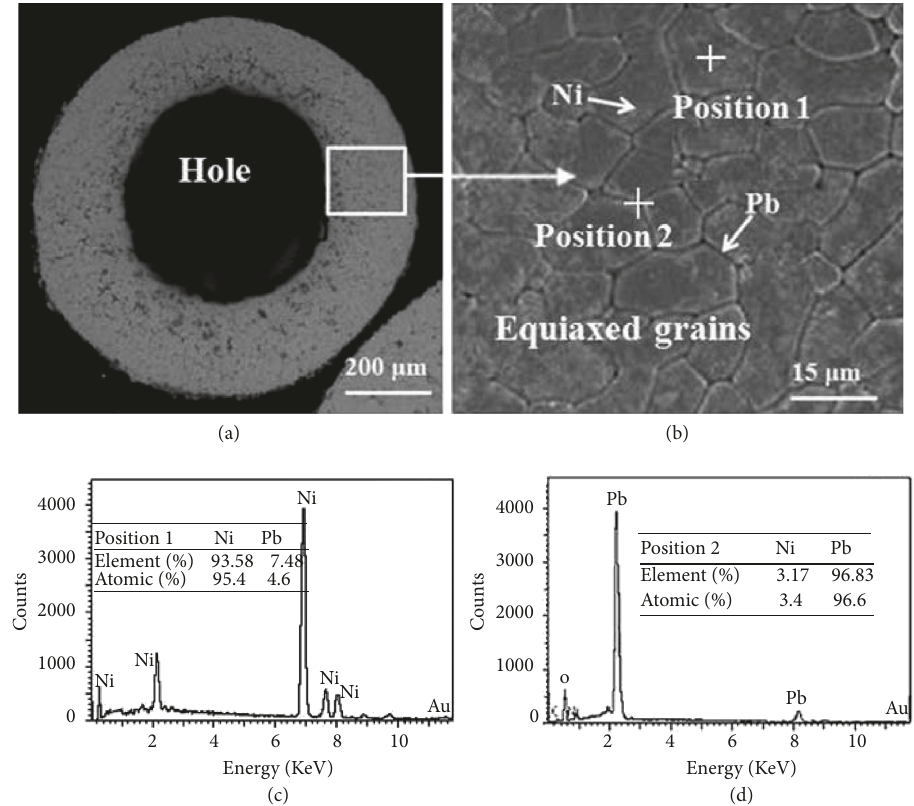
Figure 1: Microstructure and EDS spectrum of Ni-5% Pb alloy hollow particles at 30m/s: (a) the overall microstructure; (b) the mi- crostructure enlarged view; (c) the EDS spectrum of position 1; (d) the EDS spectrum of position 2.